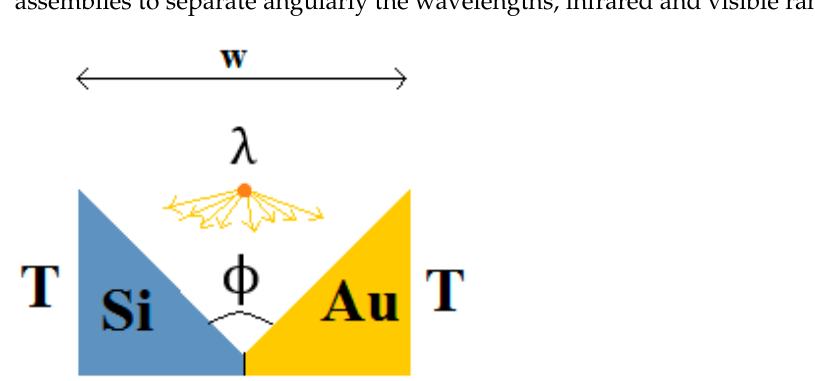
12 of 15 Figure 15. ( a , b ): Directional reflectivity; ( c , d ) apparent emissivity of a V-cavity and flat surface formed of silicon in two different spectral ranges [ 𝜆 (cid:2869) , 𝜆 (cid:2870) ], at different opening angles 𝜙 = [30°, 45°, 60°]. 4.7. Design of Asymmetric Materials Directional thermal emission can be controlled by using an asymmetric V-groove materials design. The structure is depicted in Figure 16. Our model was used to simulate